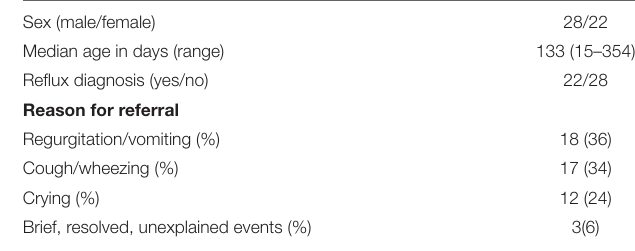
TABLE 1 | Patients